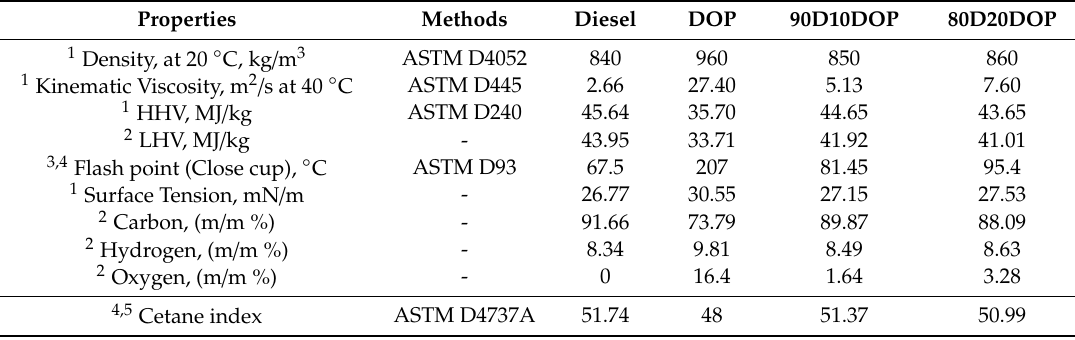
Table 2. Properties of tested fuels